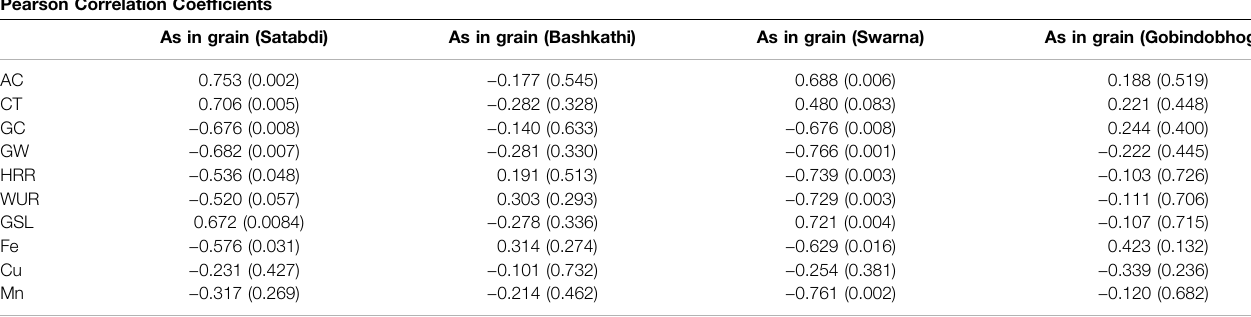
TABLE 1 | Correlation among grain As content and selected grain quality